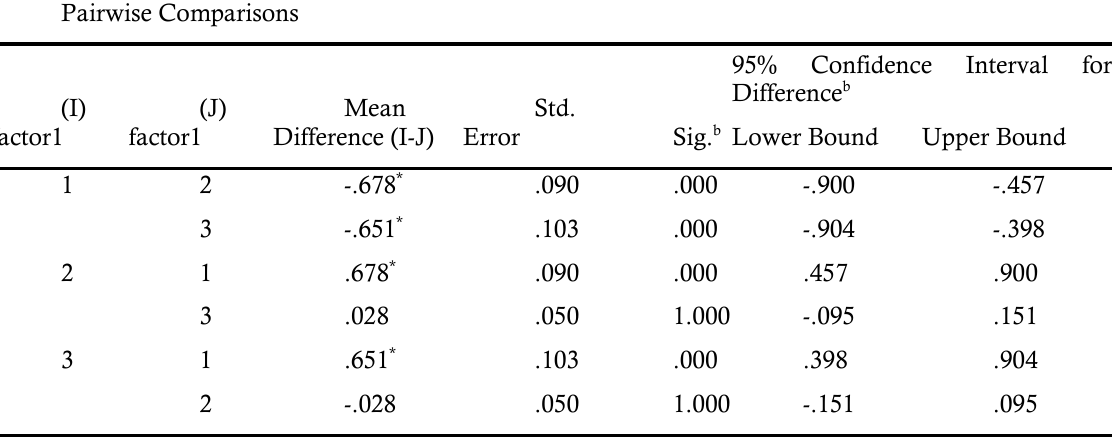
Table 3. The results of Bonferroni comparisons tests for goal orientation behavior